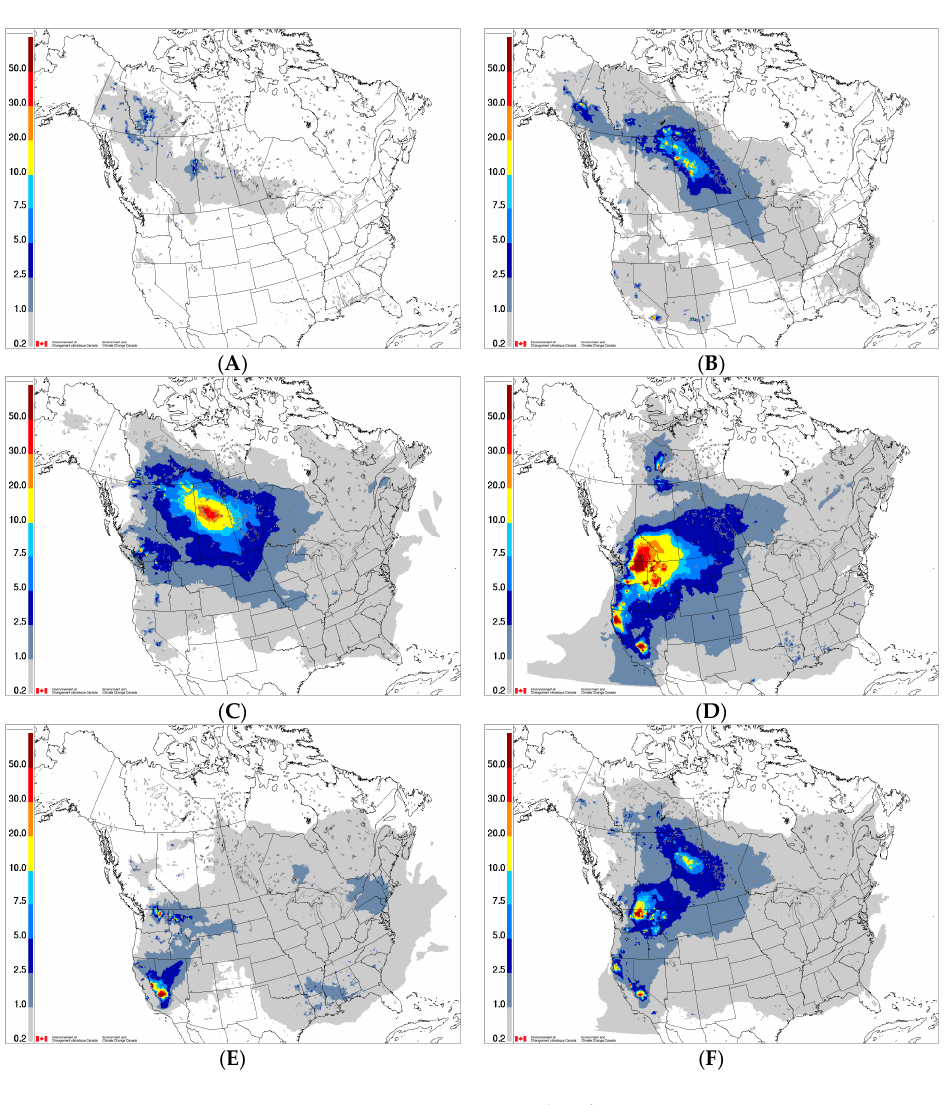
Figure 5. Same as Figure 3 but for 2015.